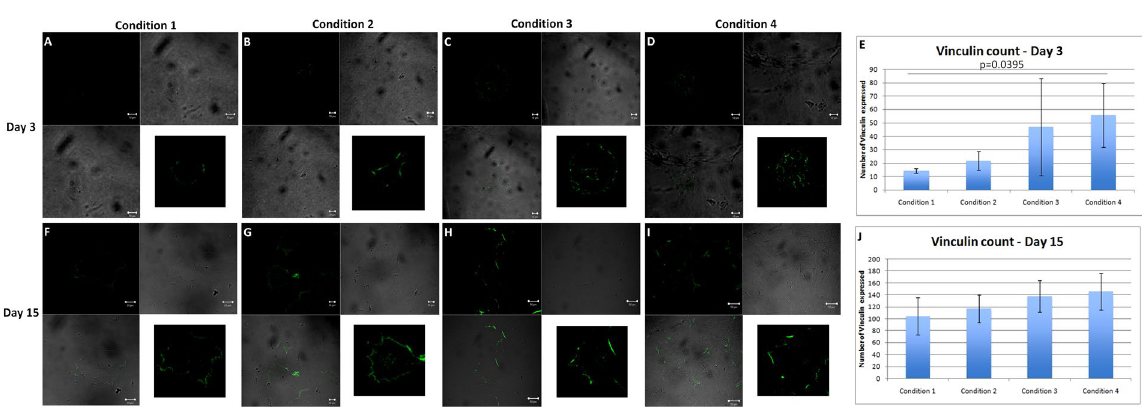
Figure 6. Expression of Vinculin as a focal adhesion marker. ( A – D ) Number of focal adhesions found in C4 was statistically higher compared to C1 (p = 0.0395). C3 also showed high number of focal adhesion points but was not significant at day 3. Scale bar = 10 µ m. This highlights that mechanical and molecular forces may induce higher focal adhesions and integrins for better cell attachment. ( F – I ) At day 15, Vinculin was expressed in all the conditions without any significant difference. ( E ) Graphical representation of number of focal adhesions that expressed per cell on day 3 and ( J ) on day 15. Scale bar for C1 and C2 = 20 µ m; C3 and C4 = 50 µ m. Image inserts show a higher magnification of the analyzed cell with the expression of